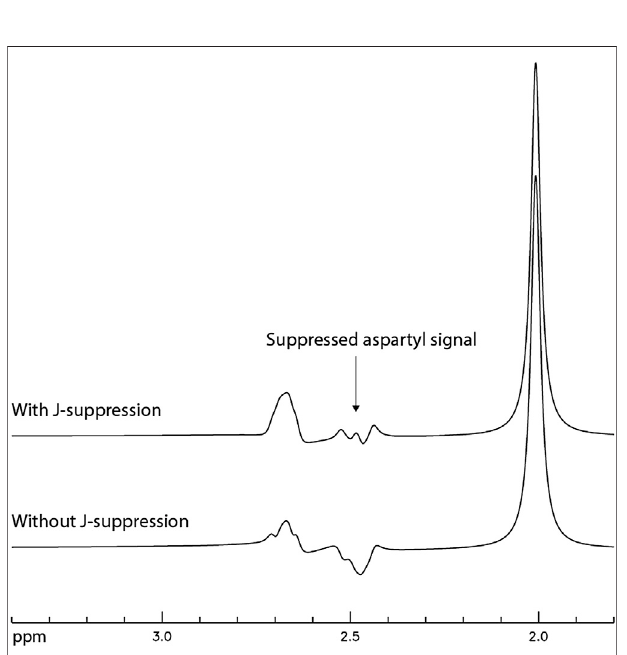
FIGURE 5 | Numerically computed NAA spectra with and without the J-suppression pulse. TE = 106 ms; TE 1 = 16 ms; J-suppression fl ip angle = 120 ° ; Time delay between the fi rst refocusing pulse and the J-suppression pulse was 40.3 ms; The spectra were broadened to a Lorentzian linewidth of 9 Hz.